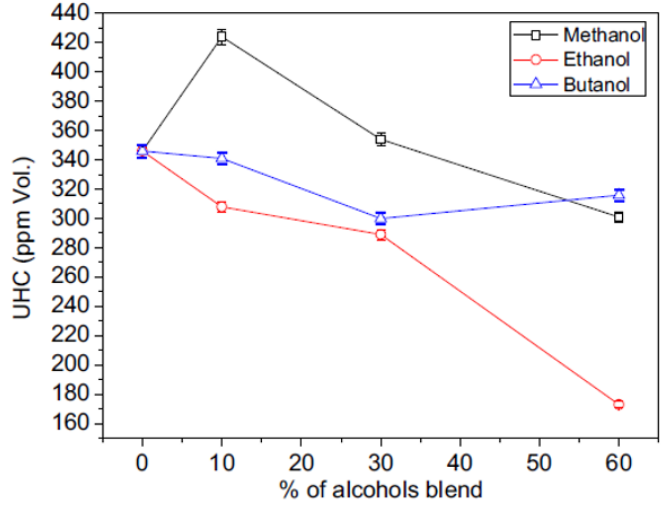
Figure 7. Variation in CO emissions with alcohol content in the blends at 3 bar BMEP and equiva- lence ratio ϕ = 1: comparison between methanol, ethanol and butanol [95]. Reproduced with per- mission from Applied Thermal Engineering; published by Elsevier, 2017. License Number: 5094081168292.